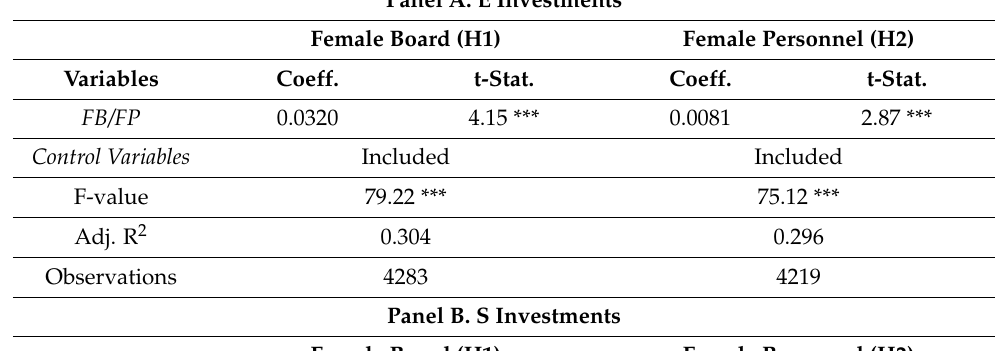
Table 6. The effect of ESG investments. Panel A. E Investments Female Board (H1) Female Personnel (H2) Variables Coeff. t-Stat. Coeff.